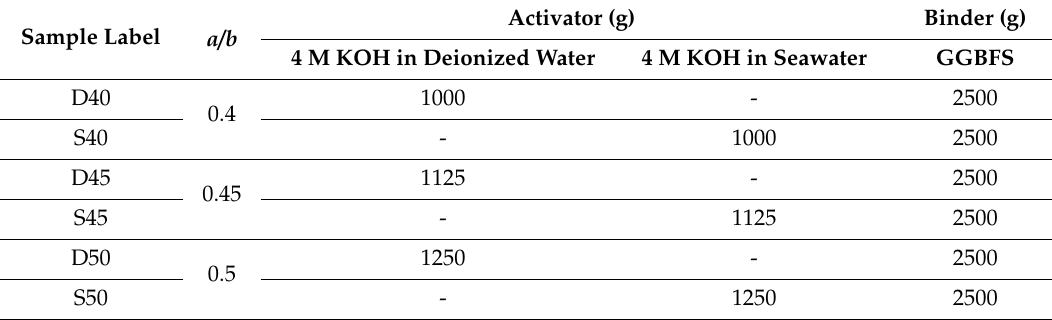
Table 3. Mixture proportions of